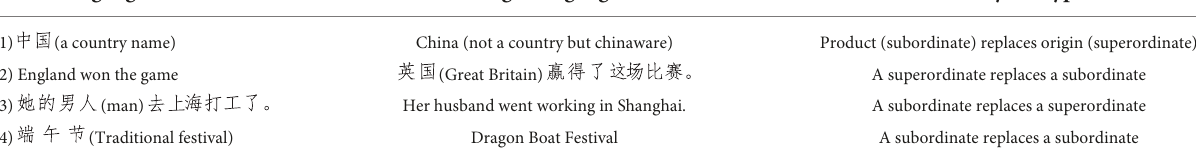
TABLE 1 Examples of metonymic process in